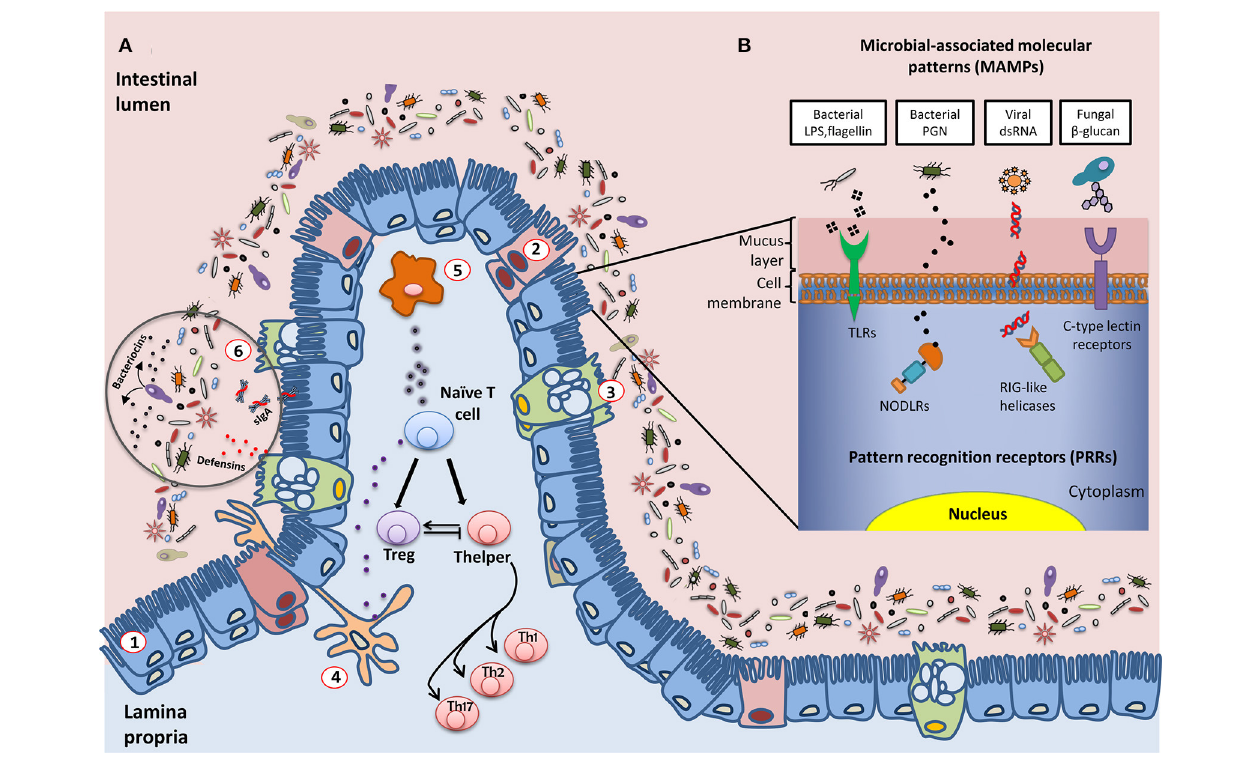
FIGURE 1 | Schematic representation of the interactions established between the intestinal microbiota and the host immune system. (A) General overview of the epithelium in contact with multiple species of microorganisms that constitute the intestinal microbiota: (1) enterocytes; (2)M cells; (3) Goblet cells; antigen presentation cells (APC): (4) dendritic cells and (5) macrophages; (6) defensins, bacteriocins, and secreted IgA (sIgA) also play an important role in controlling the levels of the different populations of microorganisms. A fine-tuned balance of Tcell maturation toward Treg or Thelper cells must be established to assure the tolerogenic response of the host immune system. (B) Examples of molecular interactions between microbial antigens and host cells through Pattern Recognition Receptors (PRRs). LPS, lipopolysaccharide; PGN, peptidoglycan; dsRNA, double-strand RNA; TLR, toll-like receptor; NODLR, nucleotide-binding